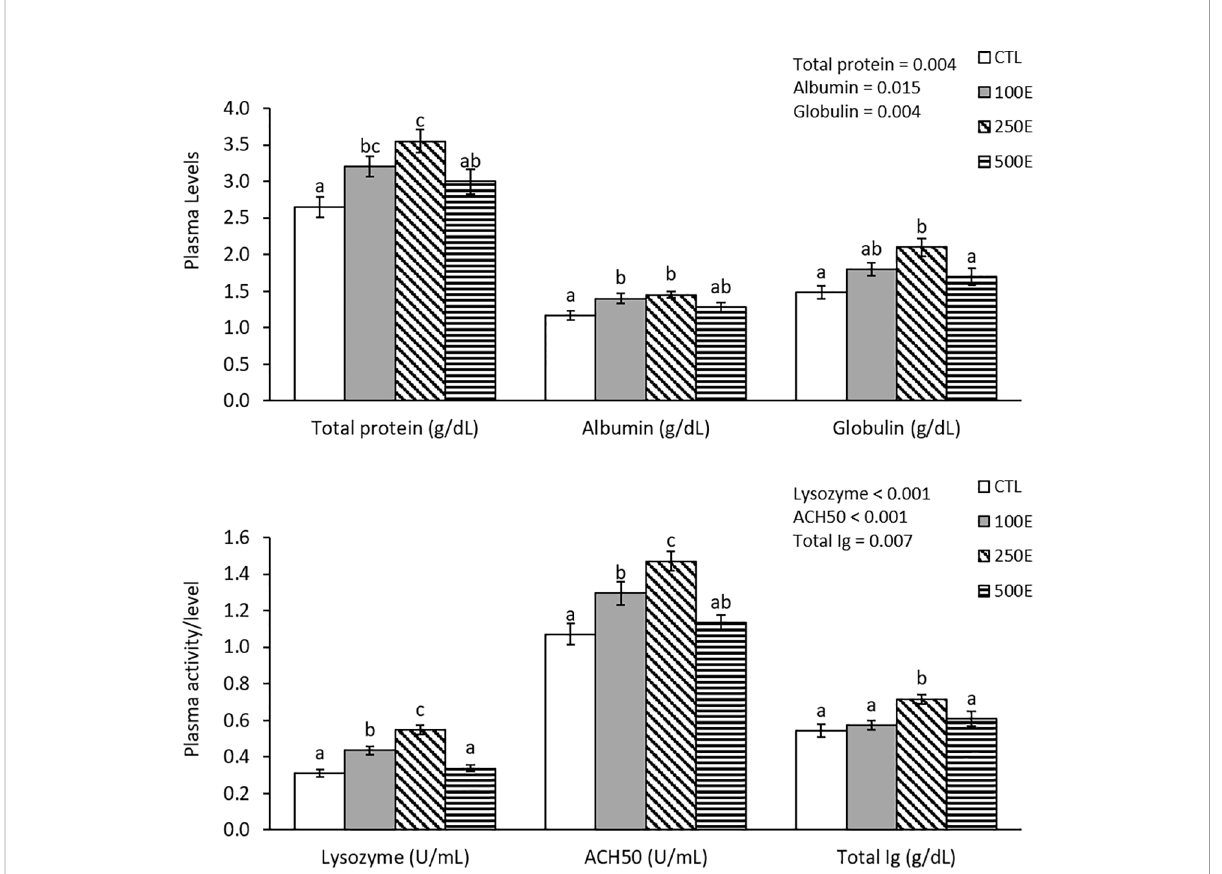
FIGURE 3 Blood plasma immunological parameters (mean ± SE) of rainbow trout fed diets supplemented with 0-500 mg/kg HE over eight weeks. Different letters above the bars indicate signi fi cant differences among the treatments (Duncan test; n =